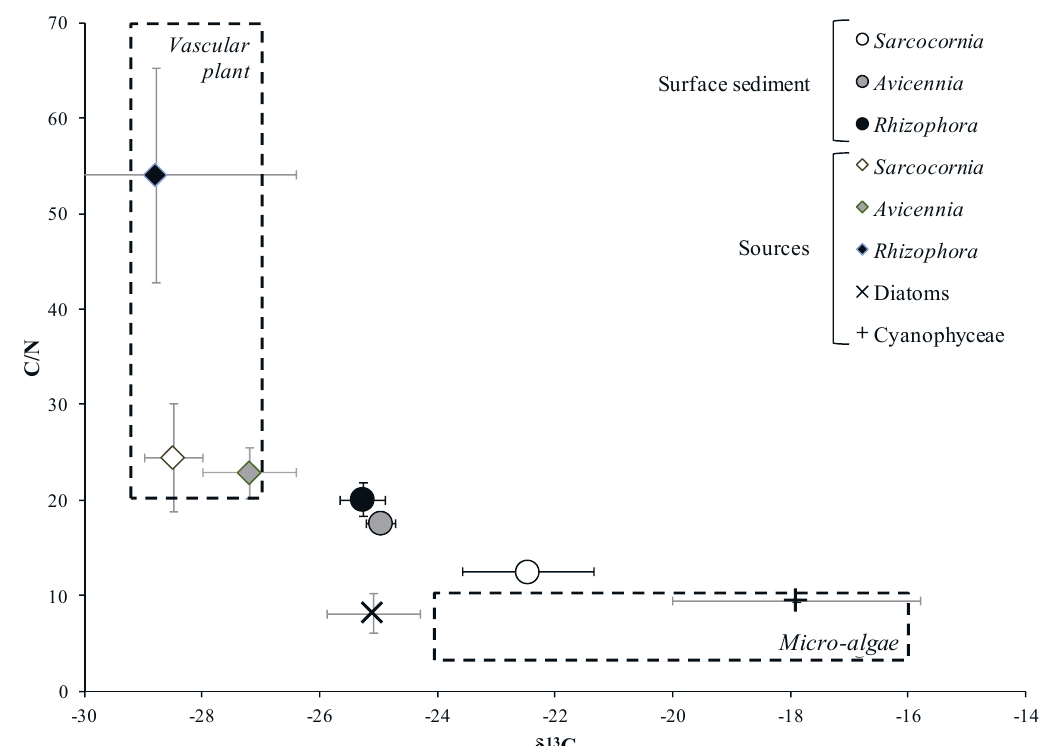
Figure 3. Mean C/N and δ 13 C values of surface sediment for each mangrove stand, and